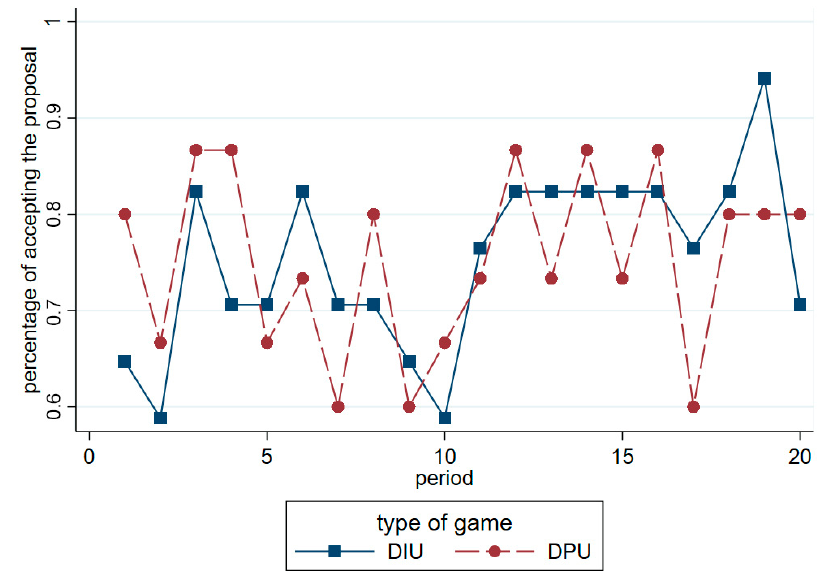
Figure 5. Percentage of receivers’ offer acceptance over time in two ultimatum treatments. Note: DIU represents the dishonesty-inducing ultimatum game; and DPU represents the dishonesty-proof ultimatum game.